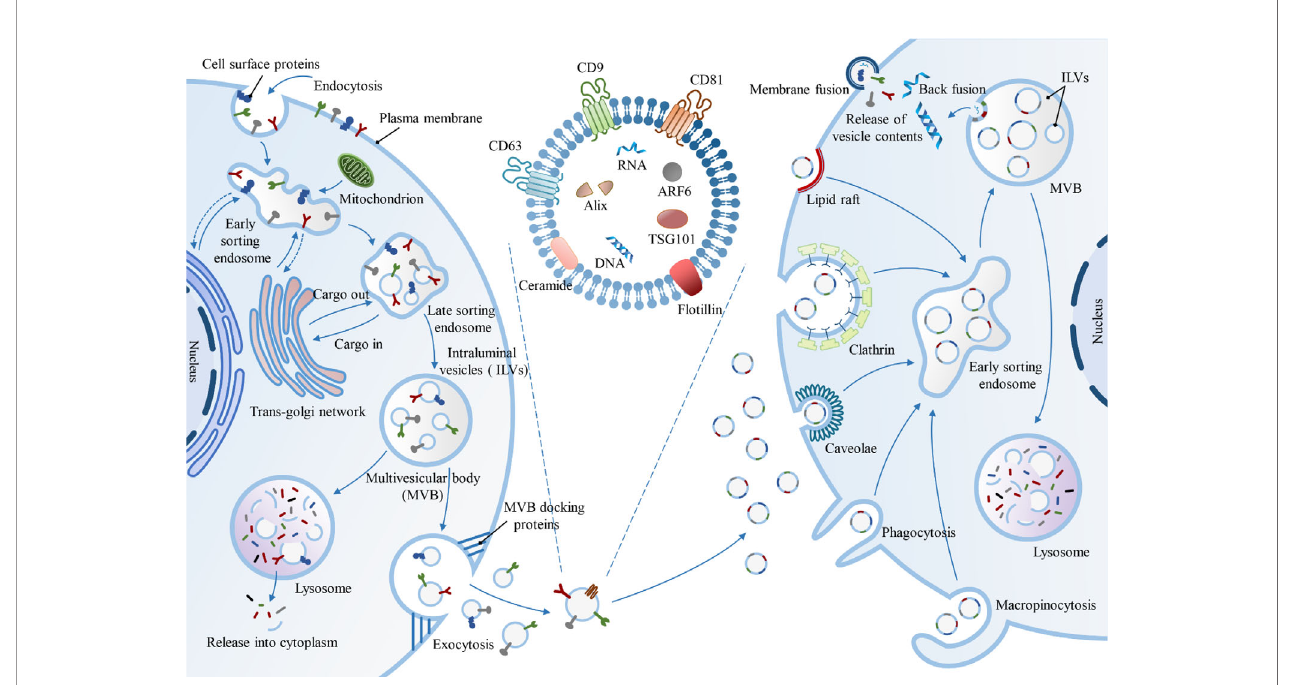
FIGURE 1 | Biogenesis, biomarkers and uptake of